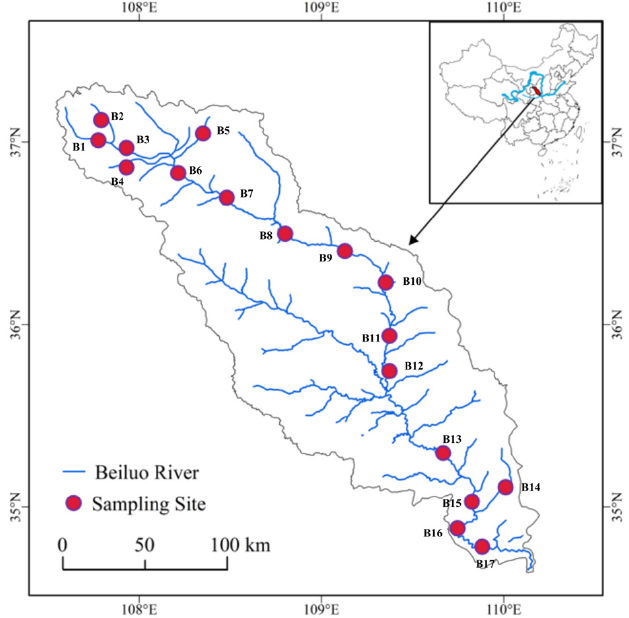
Figure 1. Study area with sampling sites marked with red dots.